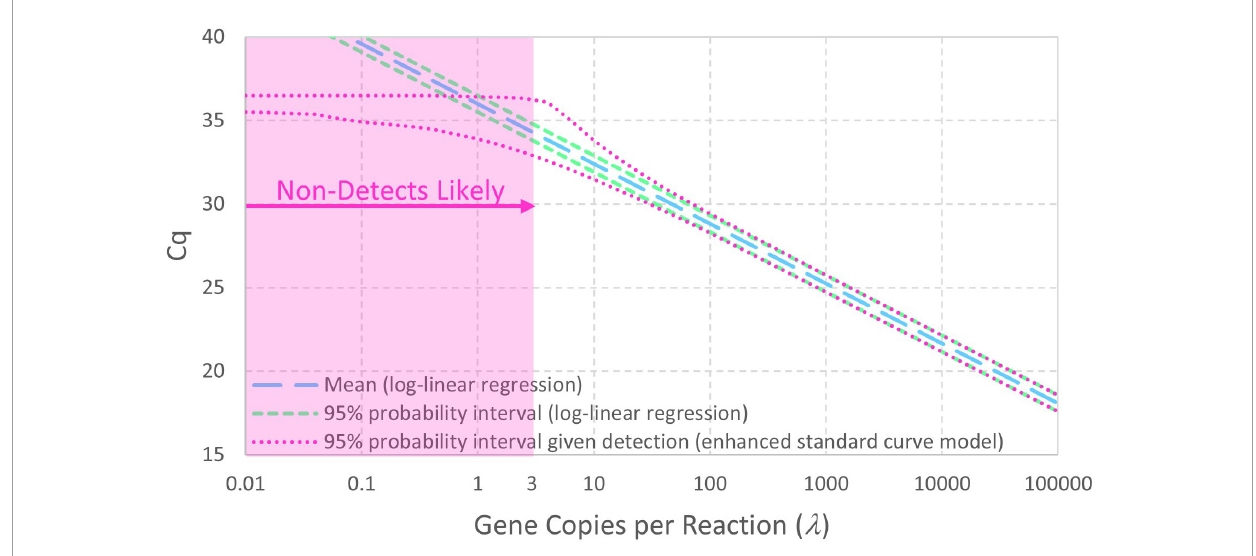
FIGURE2 Comparison of standard curve models with and without Poisson-distributed reaction random sampling error given intercept 36, amplification efficiency E = 0 . 9, and Cq residual standard deviation σ = 0 . 25. Non-detects are illustrated as likely below 3 gc/rxn, and the 95% probability interval for the enhanced standard curve model (with reaction random sampling error) is conditional on